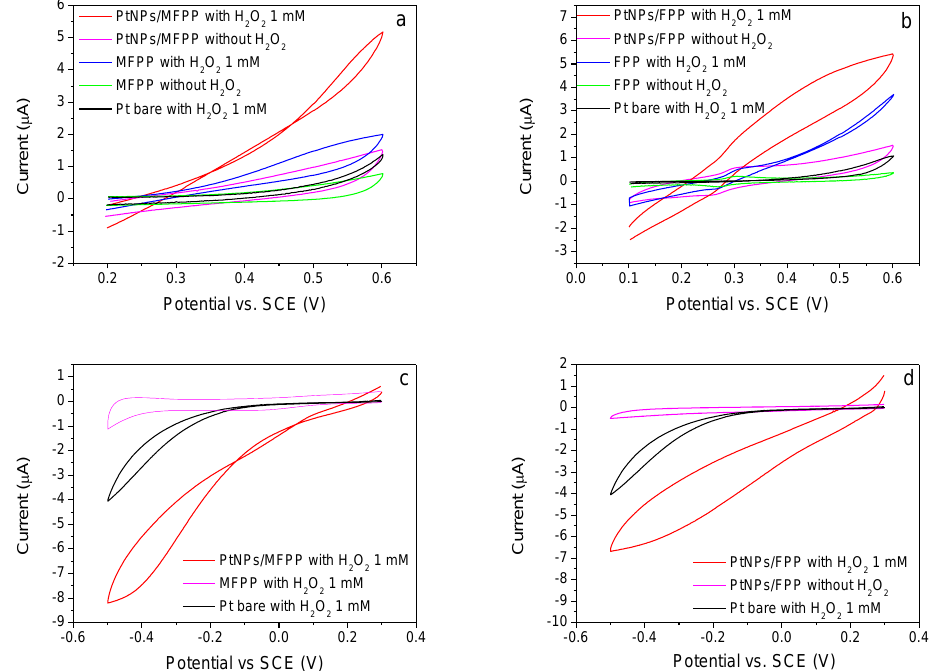
Figure 4. Anodic cyclic voltammograms of MFPP and PtNPs/MFPP ( a ), FPP and PtNPs/FPP ( b ) modified electrodes ( Γ ∼ = 3 × 10 − 10 mol Fc/cm 2 thickness film) in absence and presence of hydrogen peroxide 1 mM in deaerated 0.01 M phosphate buffer (pH 7.0)/NaClO 4 0.1 M as supporting electrolyte. ( c , d ) Cathodic cyclic voltammograms of the same PtNPs/MFPP and PtNPs/FPP modified electrodes respectively, in the same dissolution. The black cyclic voltammograms correspond to a Pt bare electrode in presence of hydrogen peroxide 1 mM in the same supporting electrolyte. Scan rate 5 mV/s.